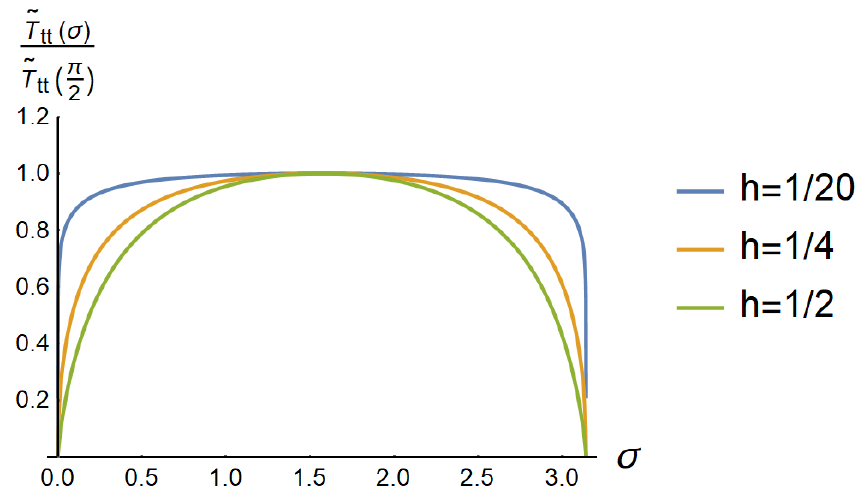
Figure 8 . Normalized energy distribution in the bulk for di(cid:11)erent h (cid:20) 1